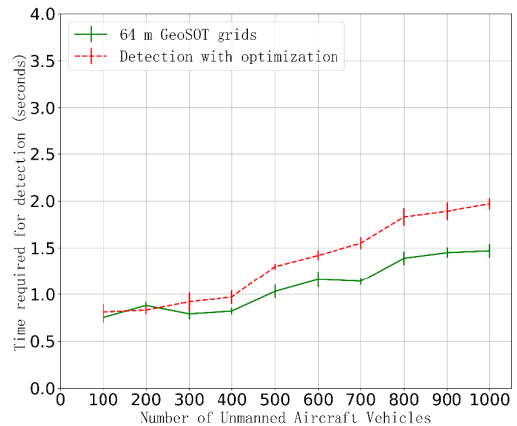
Figure 9. Time required to detect a collision after formation optimization. Collision detection with optimization is shown with a green line. The optimization is based on the premise that the UAVs are established in a fixed formation.